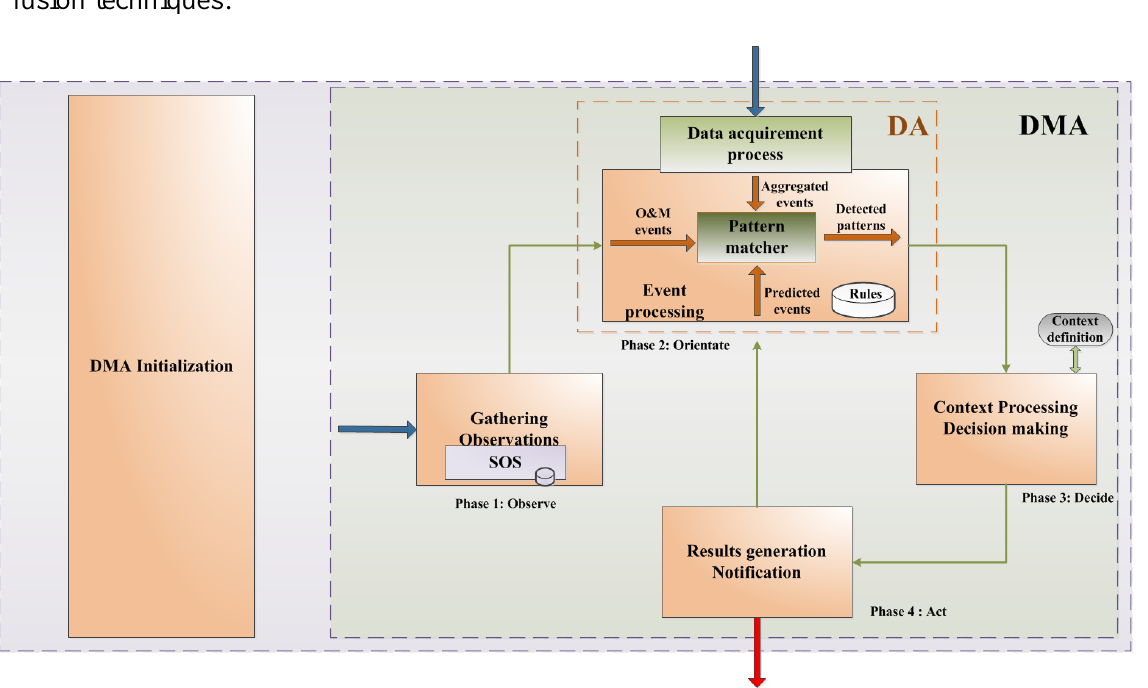
Figure 5. The architecture of the vulnerability prediction model based on sensor data fusion